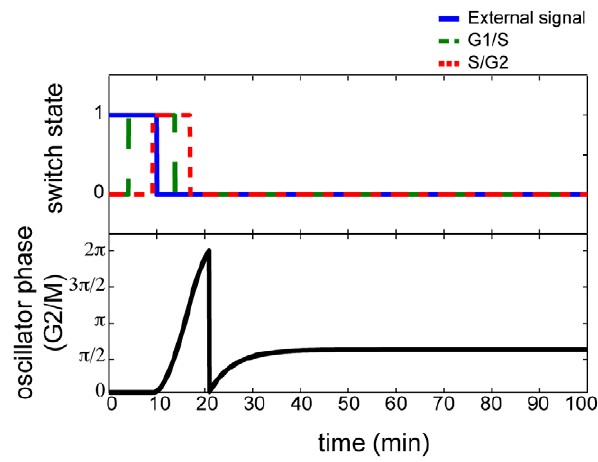
Figure 5. Simulated dynamics of the yeast cell cycle. Evolution of the states of the cell cycle modules (G1/S top, green dashed; S/G2 top, red dotted; G2/M bottom, black) in response to an external stimulus to initiate the cell cycle (top, blue solid).